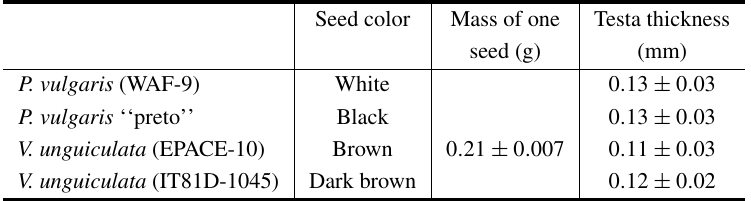
Seed color and mass and testa thickness for some legume